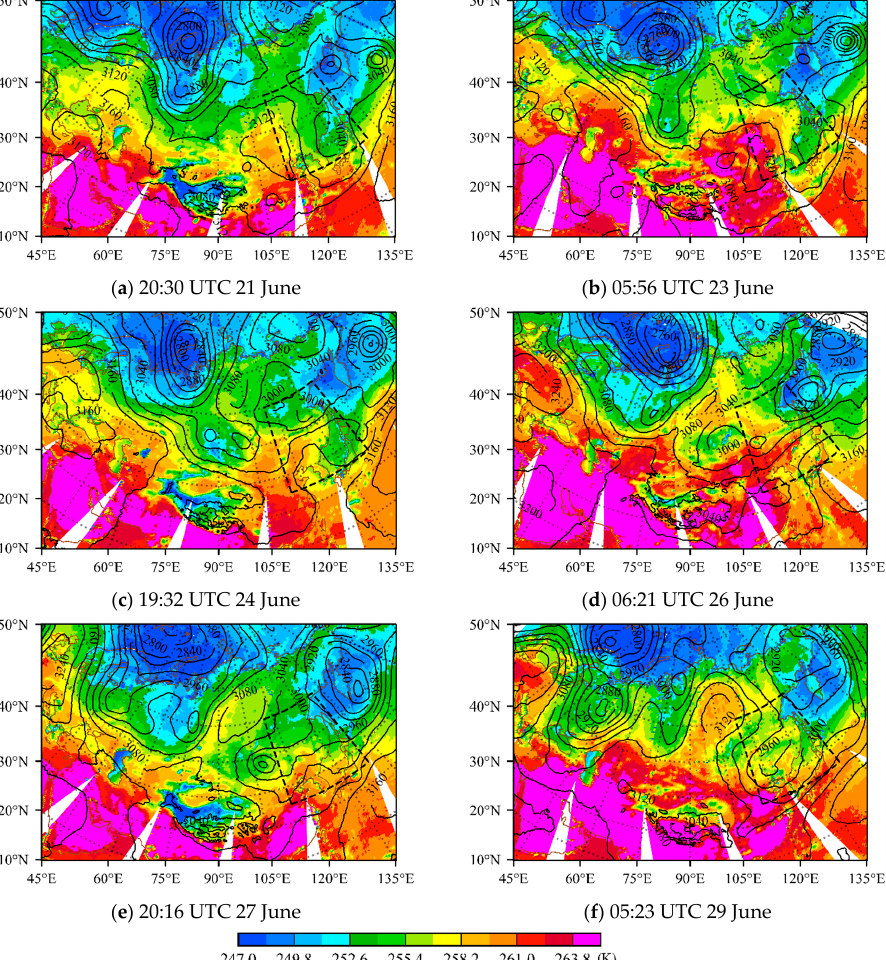
Figure 5. Spatial distributions of MWTS-2 limb-corrected brightness temperature observations (color shaded, unit: K) of channel 4 from 21 to 29 June 2019 with ERA5 700 hPa geopotential height (contours, interval: 40 gpm) at 06:00 UTC for satellite ascending node and 18:00 UTC for descending node of each day. The time when the satellite scanned the location (50°N, 90°E) is labeled below each figure.